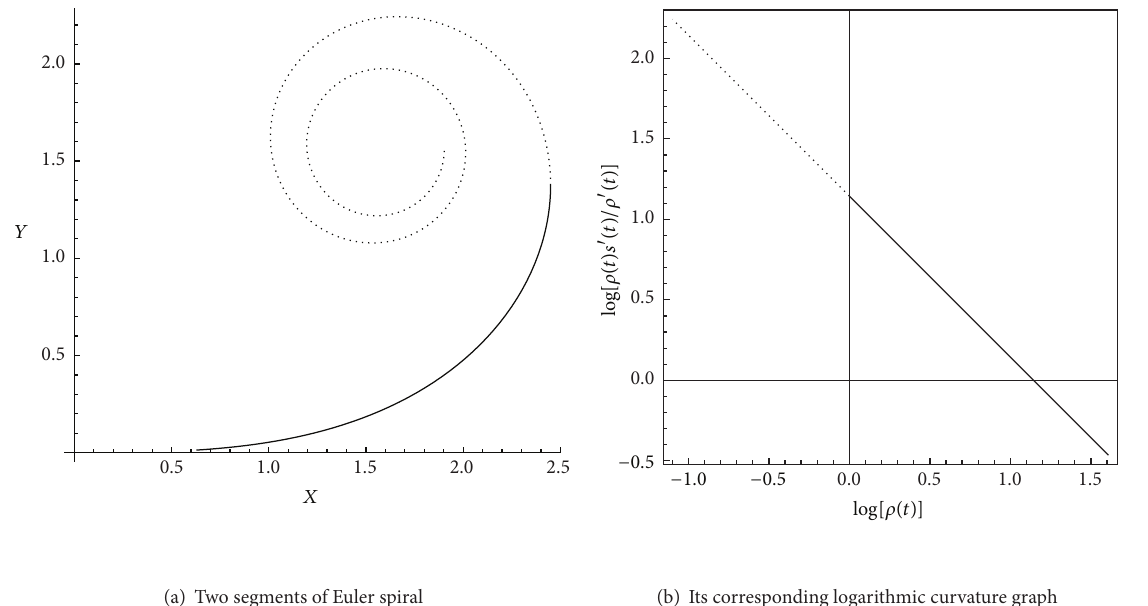
Figure 1: Euler spiral defined 𝑠 ∈ [0.2, 1] (solid line) and 𝑠 ∈ [1, 3] (dotted) and its corresponding